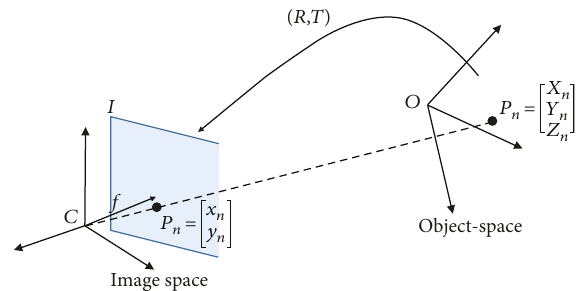
Figure 10: Change of reference from the system of the object to that of the image. C : the camera reference system; I : the image reference system; O : the object reference system; f : the camera focal length (m); R : the rotation matrix (3 × 3 matrix); T : the translation matrix (3 × 1 matrix); p n x n , y n : n th reference point position, expressed in the image reference system (pixels); P n X n , Y n , Z n : n th reference point position expressed in the object reference system (i.e., A n , F n , CF n , CR n , B n -Figure 7) could be properly viewed by the total station.